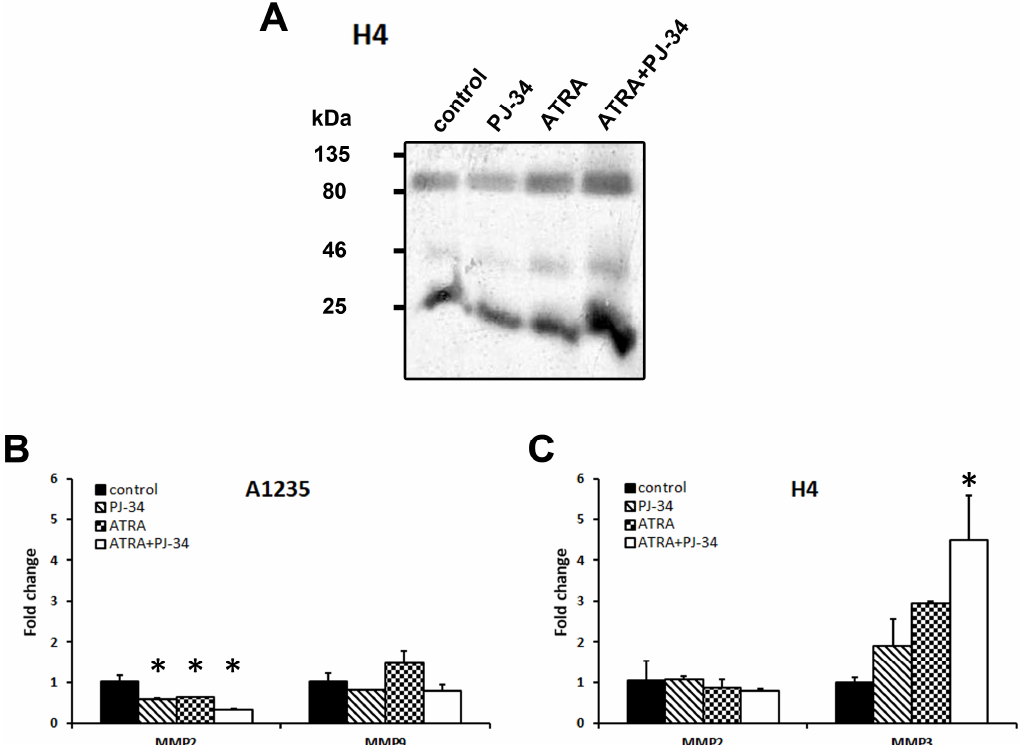
Figure 7. Metalloprotease activity and expression in A1235 and H4 cells after ATRA and PJ-34 treatment: ( A ) Zymography of H4 cells. After the prolonged treatment with 10 µM ATRA and 20 µM PJ-34 and their combination, conditioned H4 cells were collected, concentrated, and analysed by zymography on a gelatine-containing polyacrylamide gel. ( B ) qPCR analysis of MMP expression in A1235 cells; ( C ) qPCR analysis of MMP expression in H4 cells. RNA was isolated from cells after prolonged treatment, cDNA was produced and examined by qRT-PCR. Relative gene expression level was obtained by normalization of its values with those of hypoxanthine-guanine phosphoribosyltransferase ( HPRT ) and is presented as a fold change in comparison with untreated control cell values. PJ-34: cells treated with 20 µM PJ-34; ATRA: cells treated with 10 µM ATRA; ATRA + PJ-34: cells treated with 20 µM PJ-34 and 10 µM ATRA inhibitor; MMP2: metalloproteinase 2; MMP3: metalloproteinase 3; MMP9: metalloproteinase 9. * The mean values were significantly different from the control ( p < 0.05).